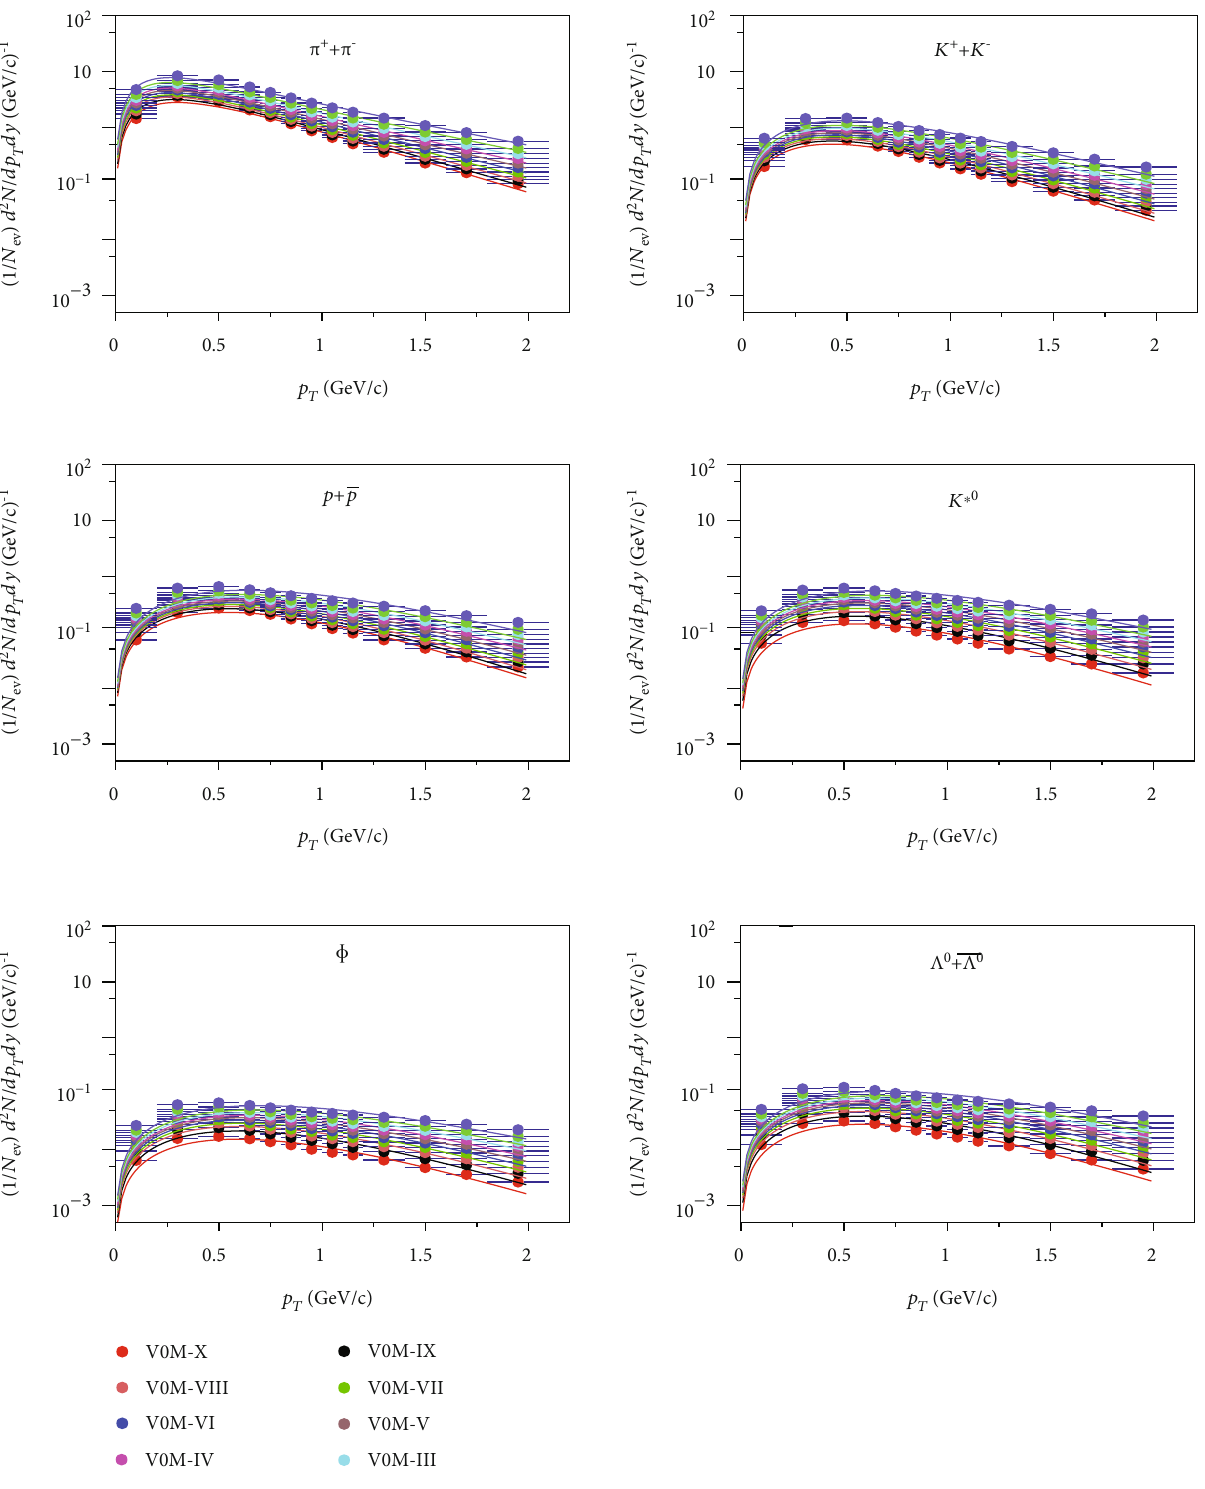
Figure 11: (Color online) Fitting of generated p -spectra of identi fi ed hadrons from PYTHIA8 using BGBW model for spherocity integrated T events in various multiplicity classes as shown in Table